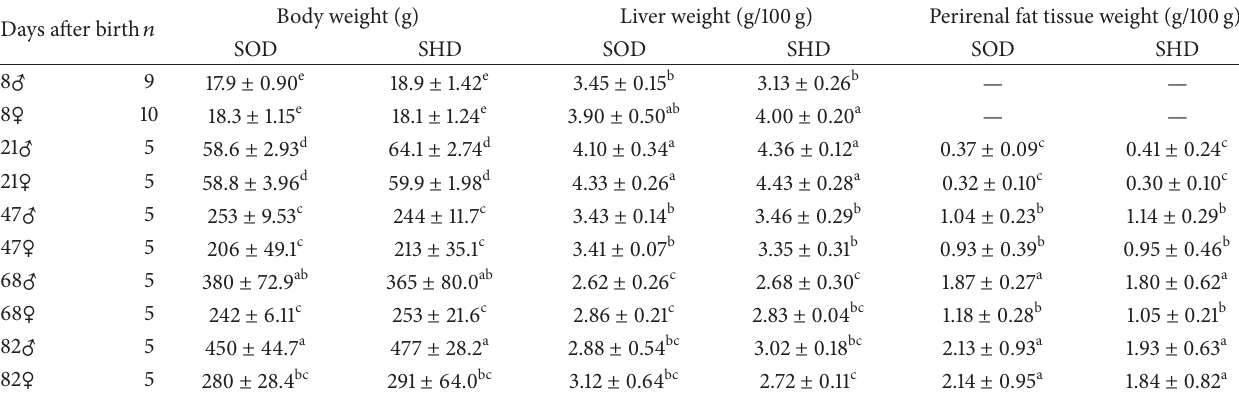
Table 5: Body, liver, and perirenal fat tissue weights of pups nursed by dams fed the soybean oil or shortening diet. Body weight (g) Liver weight (g/100g) Perirenal fat tissue weight (g/100g) Days after birth 𝑛 SOD